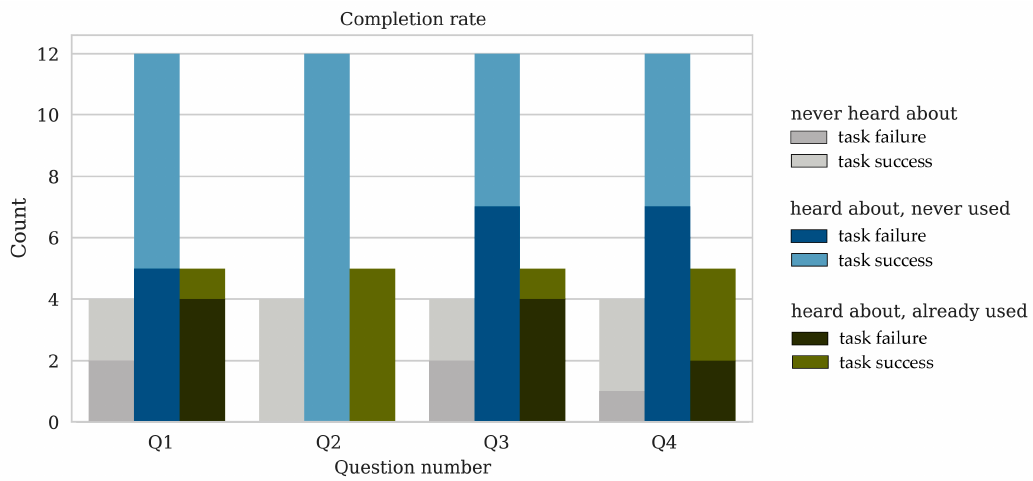
Figure 12. Completion rate for benchmark tasks grouped by questions and users’ familiarity with spatiotemporal visualization techniques.